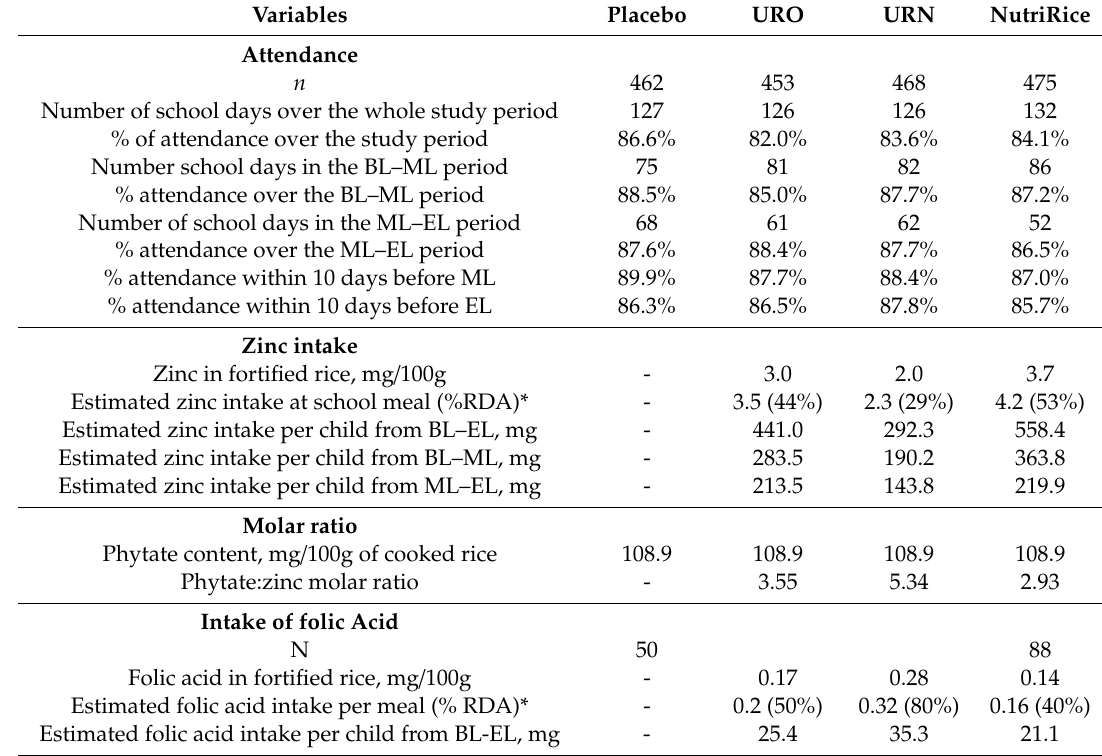
Table 3. Dietary information and attendance of each intervention